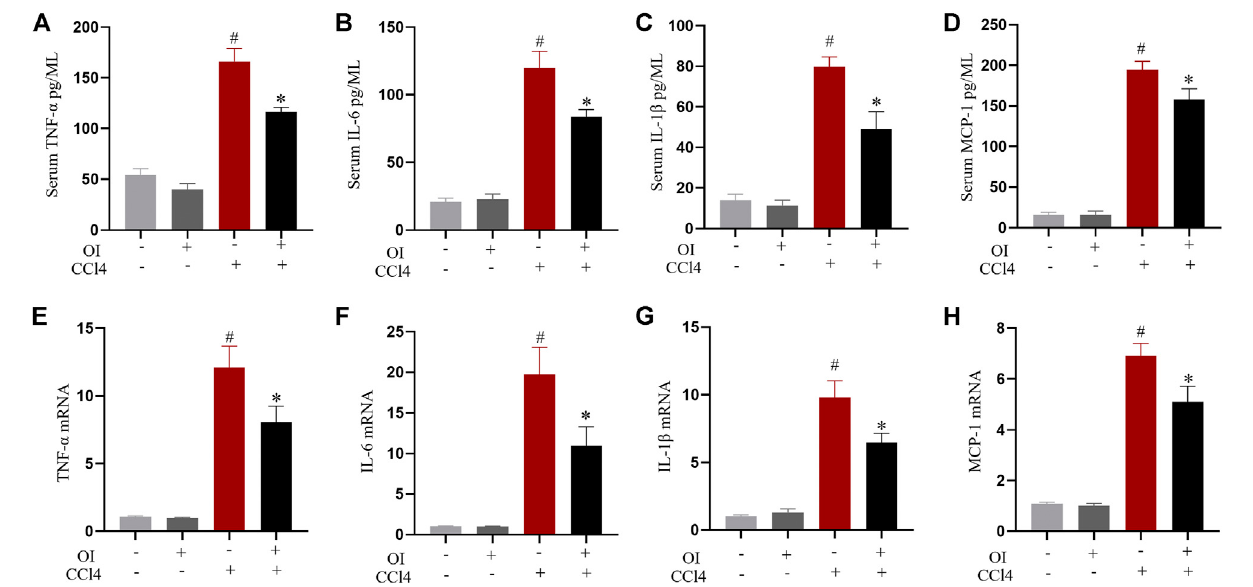
FIGURE3| EffectofOIonserumcytokinelevelsandtranscriptionofcytokinesinlivertissuesinmice.ELISAineachgroupmeasuredserumlevelsofTNF- α (A) ,IL-6 (B) ,IL-1 β (C) ,andMCP-1 (D) .ThemRNAlevelsofTNF- α (E) ,IL-6 (F) ,IL-1 β (G) ,andMCP-1 (H) inhepatic tissuesweremeasured ineach group.Dataareexpressedas mean ± SEM ( n (cid:1) 5 for each group); # p < 0.05 vs. control group; * p < 0.05 vs. CCl4-treated